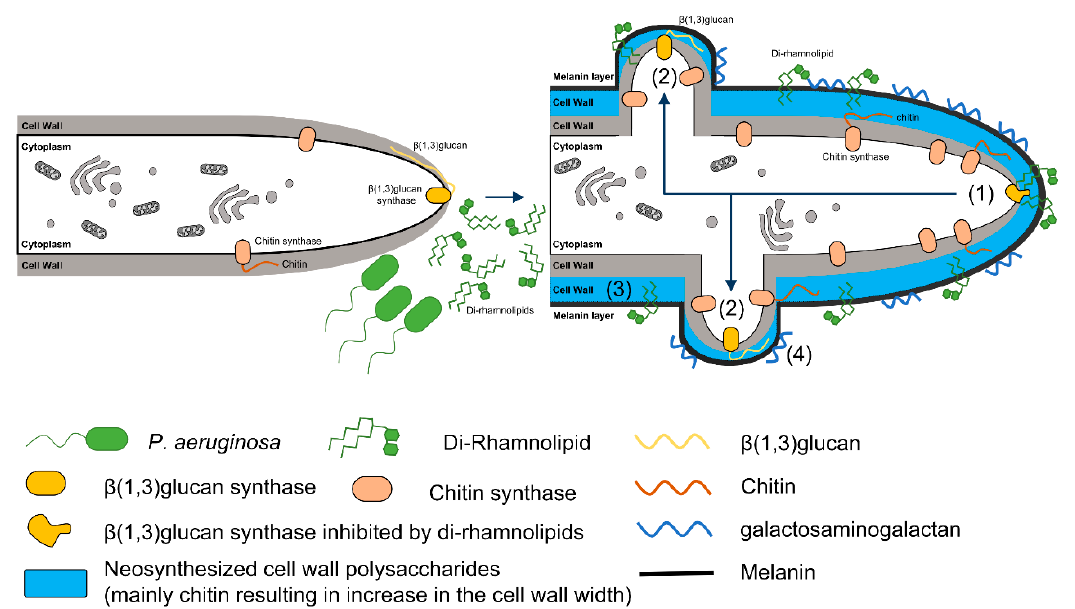
Figure 1. Diagram illustrating the mode of action of P. aeruginosa dirhamnolipids on A. fumigatus growth. Dirhamnolipids inhibit β 1,3 glucan synthase (GS) at the hyphal tip (1). This inhibition stimulates the formation of new apices (2), containing active GS which will be further inhibited by the dirhamnolipids, giving the multibranched phenotype with short apical cells. The inhibition of the β 1,3 glucan synthesis is compensated by an increase in chitin synthesis (3). Dirhamnolipids also induce melanin and galactosaminogalactan production in the extracellular matrix